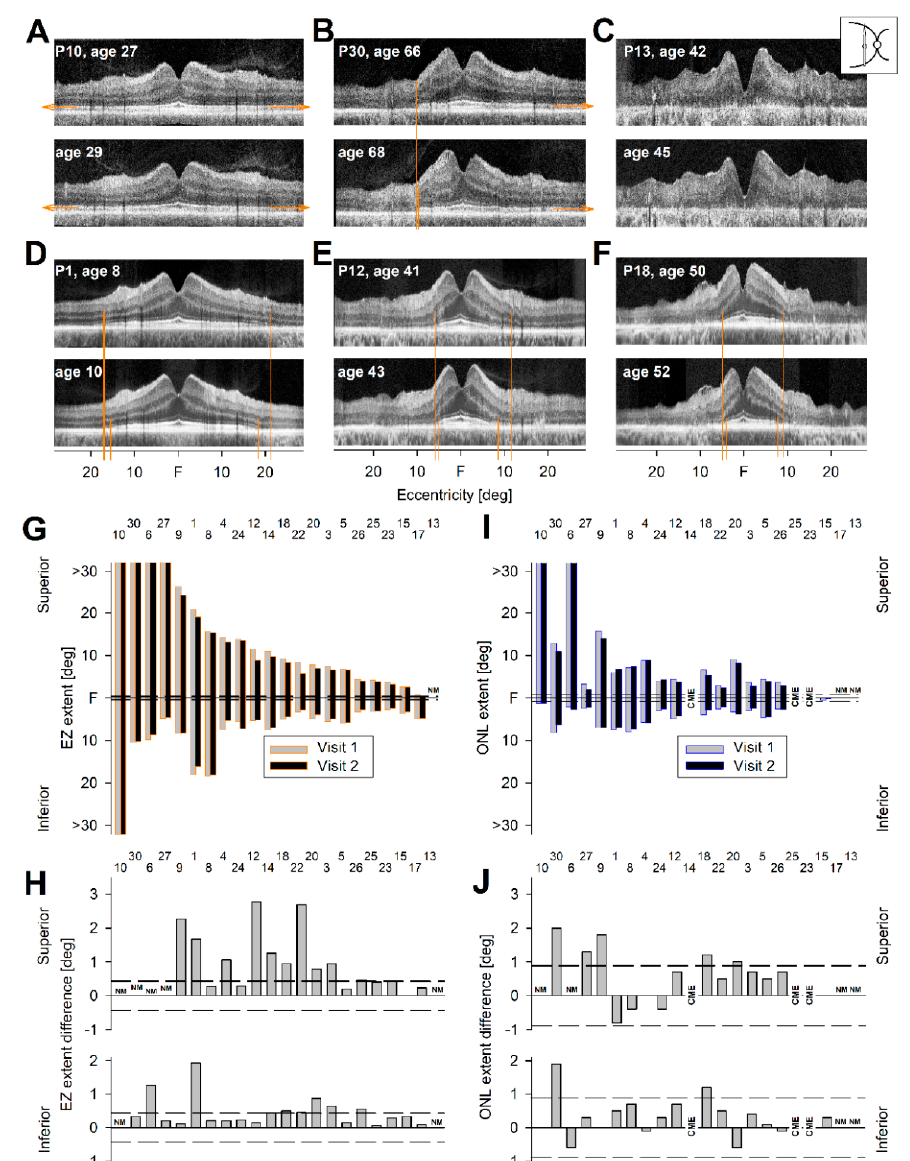
Figure 4. Serial vertical OCT scans over a two-year interval in RHO -adRP patients. ( A – C ) Serial scans illustrating the reasons why change in EZ extent could not be measured. ( A ) Vertical scan of a 27-year-old G106R patient at two timepoints separated by two years. Note: Left eye is used for this demonstration; right eye was used in Figure 2B. ( B ) Vertical scan in a 66-year-old P23H patient at baseline and two years later. ( C ) Vertical scan in a 42-year-old T58R patient at baseline and then two years later. ( D – F ) Serial scans showing measurable EZ extents in both superior and inferior retinal segments in 8-year-old, 41-year-old, and 50-year-old patients, all with P23H RHO mutations. ( G ) Quantitation of all 22 patients’ EZ extents from fovea into superior and inferior retina at baseline (gray with orange border) plotted adjacent to the subsequent visit two years later (black with orange border). Patient numbers are above the data in G – J . ( H ) Comparison of the differences between baseline and two-year interval data for EZ extent superiorly and inferiorly. Dashed lines indicate the intervisit variability limits. ( I ) Quantitation of all 22 patients’ ONL extents from fovea into superior and inferior retina at baseline (gray with blue border) plotted adjacent to the subsequent visit two years later (black with blue border). ( J ) Comparison of the differences between baseline and two-year interval data for ONL extent superiorly and inferiorly. Dashed lines indicate the intervisit variability limits. CME, cystoid macular edema; NM, not measurable (for different reasons; see text).